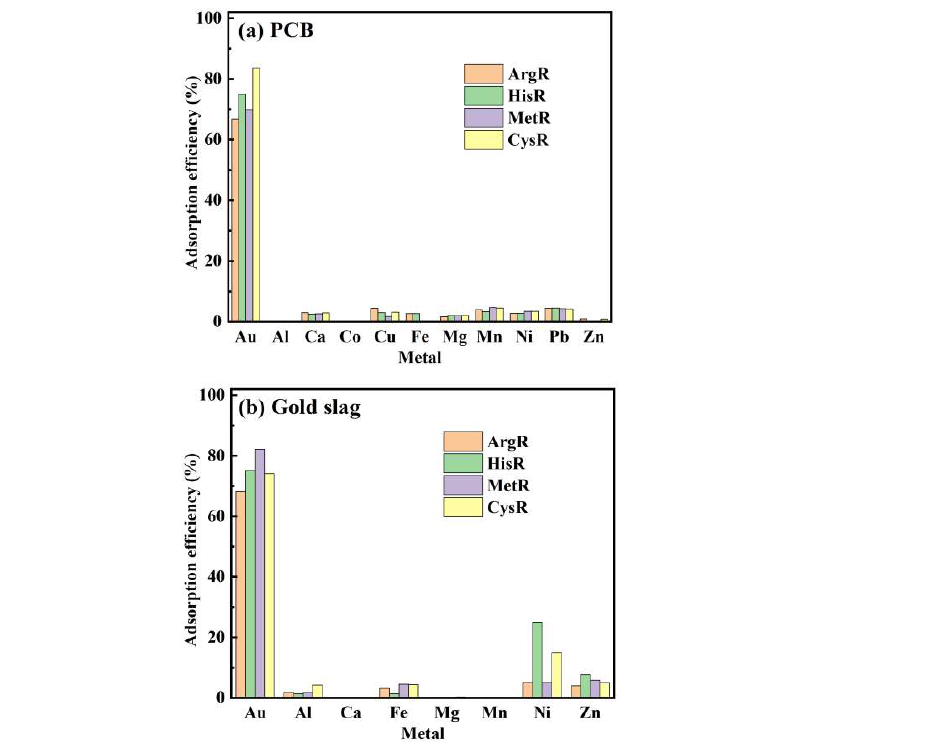
g-GMA; Figure S3: The adsorption kinetics of amino acid resins for Au(III) ions; Figure S4: FTIR spectra of ArgR, HisR, MetR and CysR; Figure S5: EDX images of ArgR after Au ( Ⅲ ) adsorption; Figure S6: EDX images of HisR after Au ( Ⅲ ) adsorption; Figure S7: EDX images of MetR after Au ( Ⅲ ) adsorption; Figure S8: EDX images of CysR after Au ( Ⅲ ) adsorption; Table S1: BET surface areas of MCC, MCC-g-GMA and the amino acid resins; Table S2: Kinetic parameters and correlation coefficients (R2) of the amino acid resins.